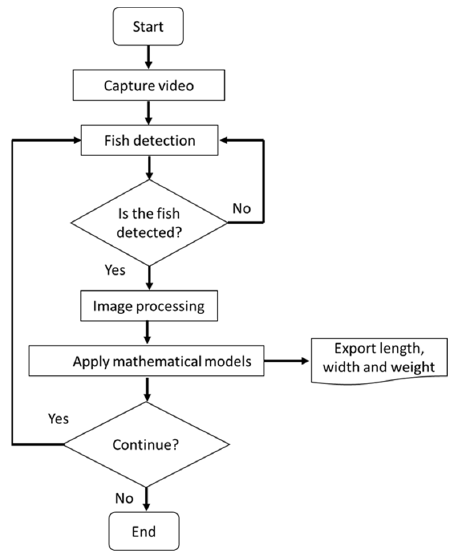
Figure 6. Flow chart of the image processing.